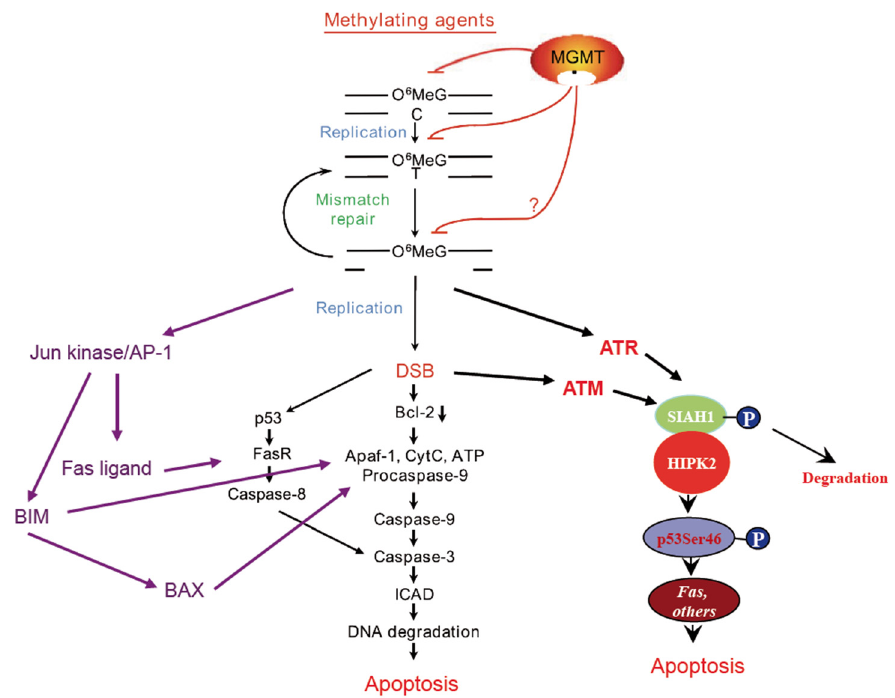
Figure 1. Cell death pathways triggered by the temozolomide-induced DNA lesion O 6 -methylguanine. Although TMZ, like other S N 1 alkylators, induces more than a dozen DNA adducts, O 6 MeG is the key cytotoxic lesion and MGMT the primary node of drug resistance (reviewed in Reference [22]). The damage is converted into DSBs and, in p53 mutated cells, stimulates mitochondrial apoptosis, a hallmark of which is Bcl-2 decline [8]. In p53 wild-type cells, apoptosis is additionally driven by death receptor triggered caspase-8 activation, which requires upregulation of the Fas receptor controlled by p53 [12], and the Fas ligand, which is under control of AP-1. Additionally, the AP-1 dependent BIM / BAX apoptosis pathway [21], as well as the SIAH1 / HIPK2-p53Ser46 pathway become activated [19] thus contributing to cell death executed by apoptosis. The model is based on experiments with TMZ doses of ≤ 50 µ M, which were used for glioblastoma cell treatment in the cited works.